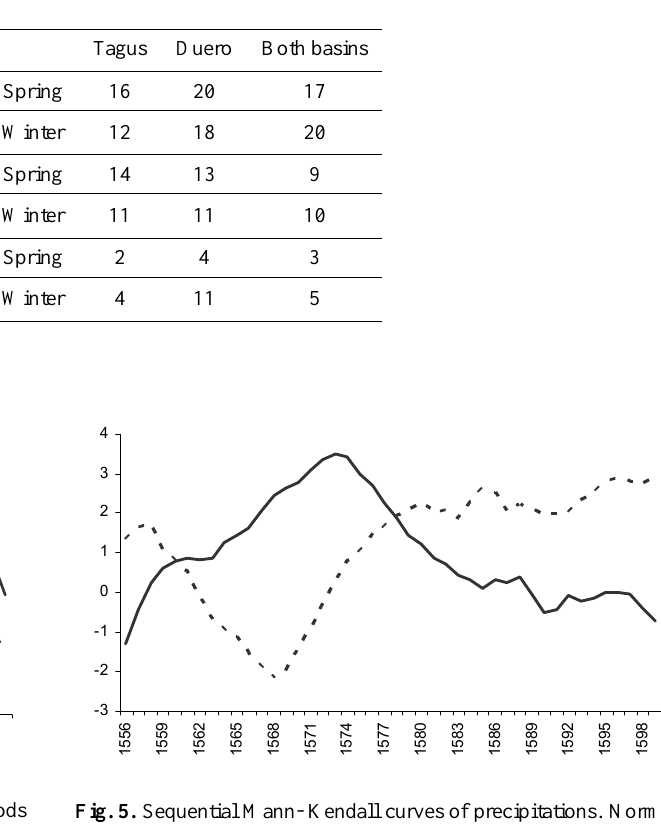
Figure 5. Sequential Mann- Kendall curves of precipitations. Normal series (solid line), backward series (broken line). Tagus and Duero basins. Y-axe =Man-Kendall index (u t ) and (u t’ ) . X-axe= years.